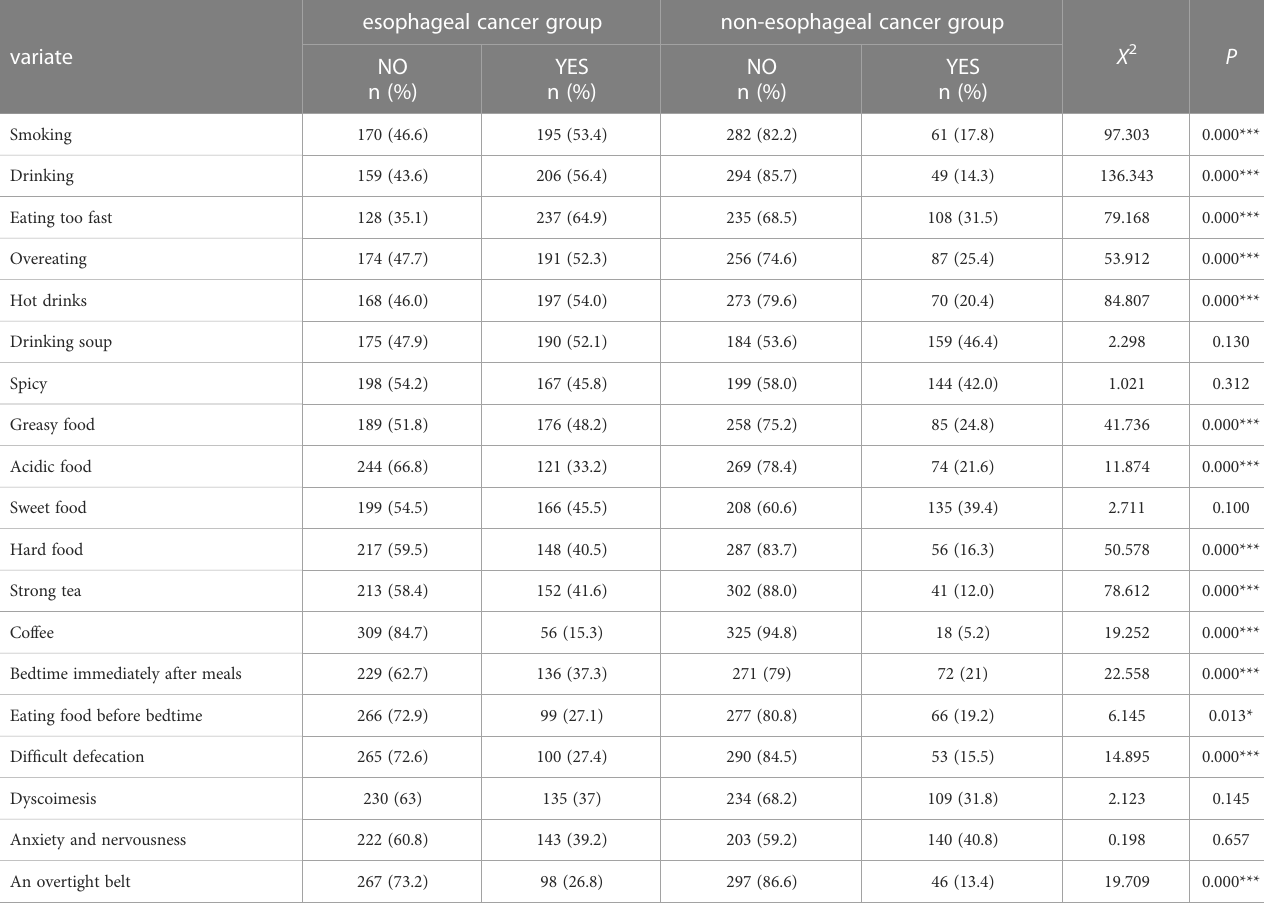
TABLE 2 Univariate analysis of unhealthy living habit for esophageal cancer.